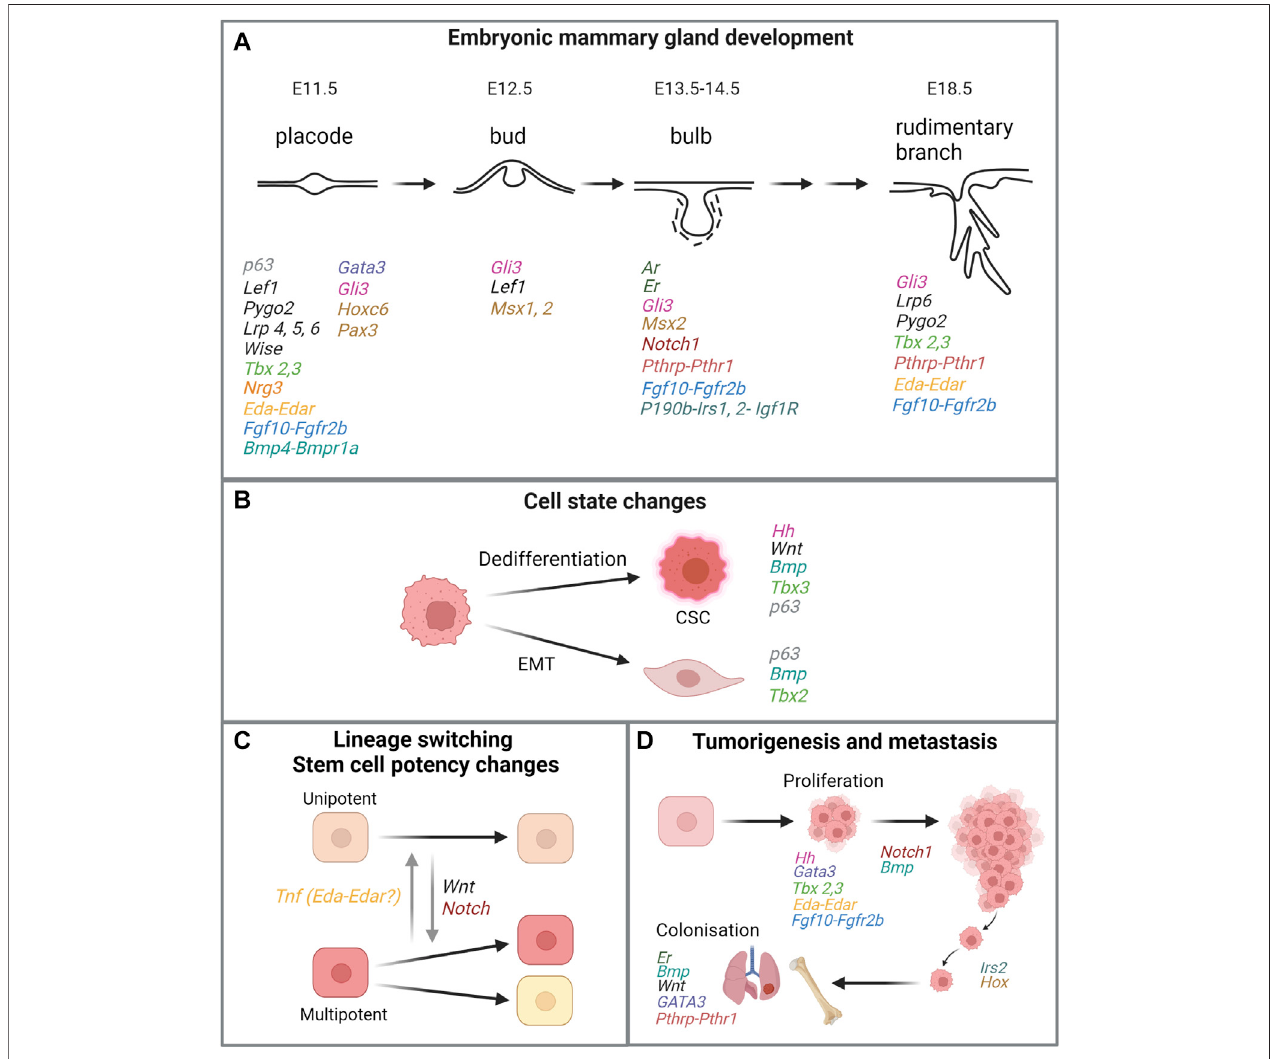
FIGURE 4 | Similarities of genes or signaling pathways critical in embryonic mammary gland development and processes in breast cancer. (A) Key stages in embryonicmammaryglanddevelopmentandgenesandtheirassociatedpathwaysinvolvedintherespectivestages.ForMR-speci fi cdevelopmentalprocessesthatare regulated by relevant genes and signaling pathways, please refer to main text. (B,C,D) Processes that are linked to tumorigenesis and metastasis and mediated by the same genes or signaling pathways important for embryonic mammary gland development. Genes in the same signaling pathway are coded in the same colour. Figure created with